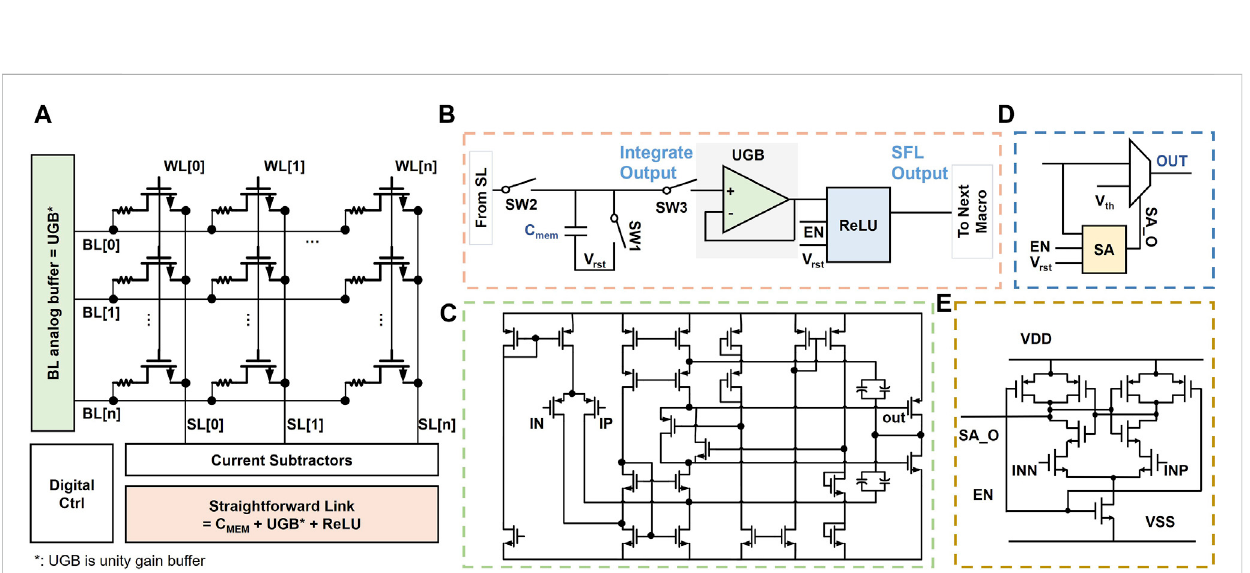
FIGURE 2 (A) ADC-less RRAM PE design; (B) schematic representation of the straightforward link (SFL). The SFL consists of a capacitor, a unity gain buffer (UGB), and a ReLU module; (C) ampli fi er in the UGB or BL analog buffer; (D) the ReLU module comprises a sense ampli fi er (SA) and a 2-to-1 MUX. (E) The SA is a latch-based voltage mode